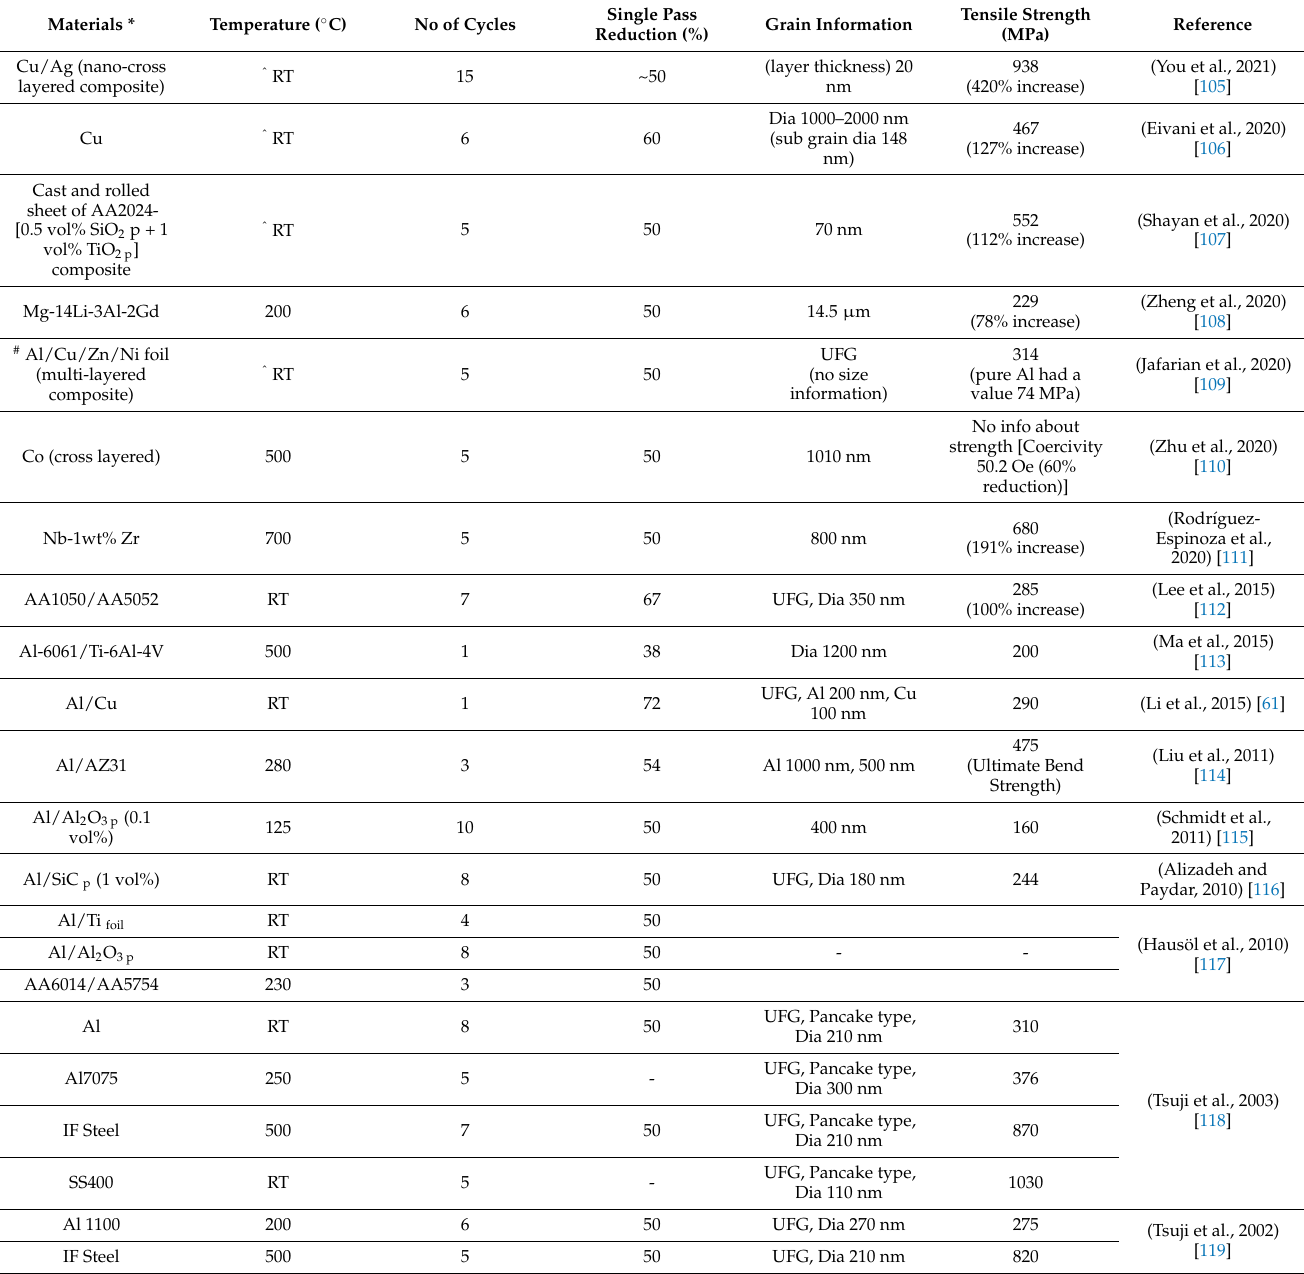
Table 4. Review of ARB